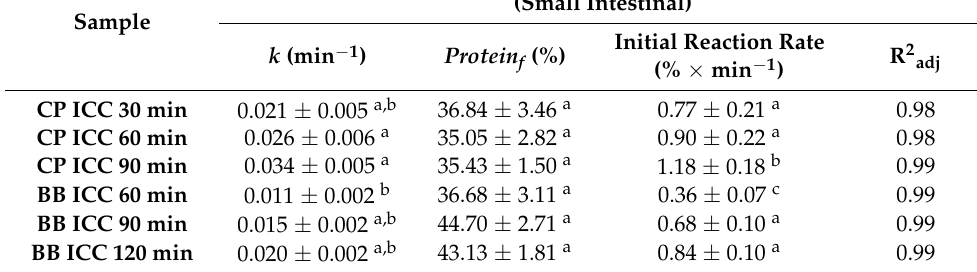
Table 5. Estimated kinetic parameters ± standard deviation of in vitro protein digestion of individual cotyledon cells (ICC) from chickpea (CP) or black bean (BB) (aligned to equivalent hardness levels using hydrothermal treatment for 30, 60, or 90 min and 60, 90, or 120 min, respectively. Protein digestion kinetic parameters were estimated by fitting the experimental data to a fractional conversion model (Equation (4)). Mean values (within a column) with different superscript letters are significantly different based on 95% confidence